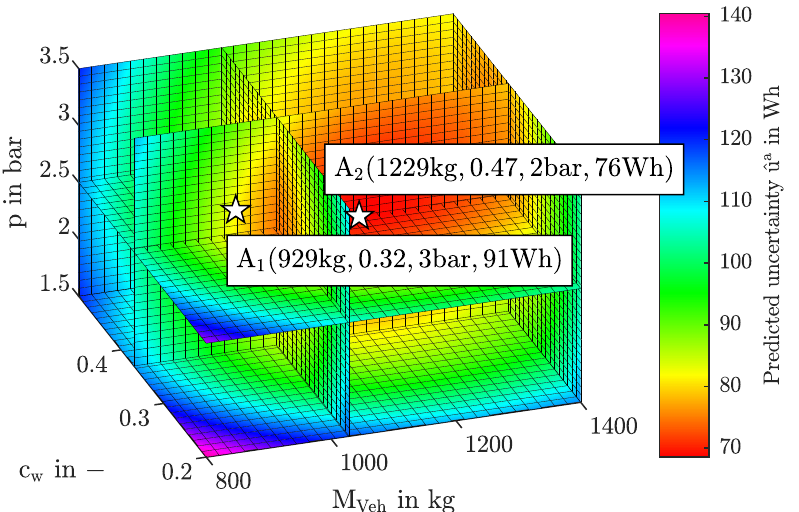
(cid:0) (cid:1) θ a showing the predicted model uncertainty